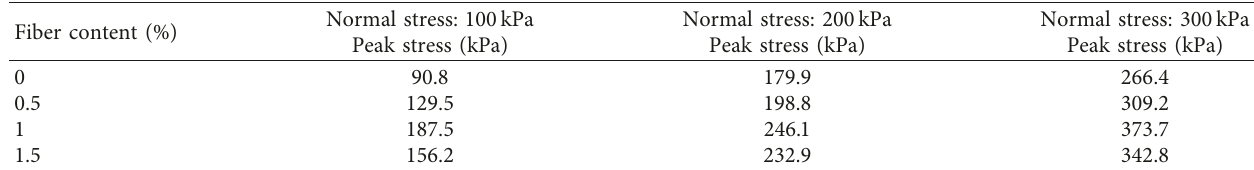
Figure 6: Shear stress-strain curves of reinforced fly ash-soil with different fiber contents and vertical normal stresses: (a) σ σ n 200kPa, and (c) σ n 300kPa. (cid:31) (cid:31) Table 3: Peak shear strength of reinforced